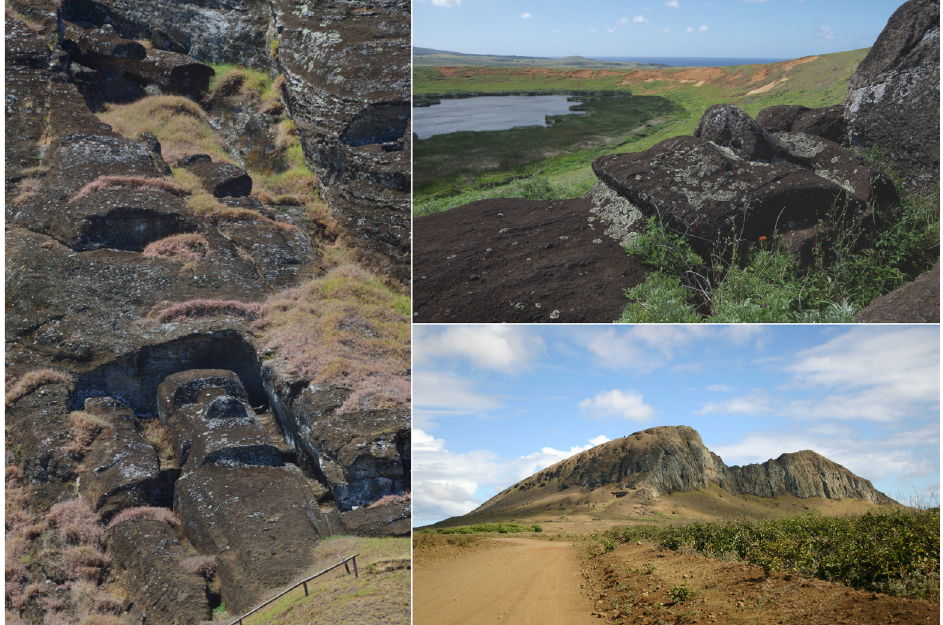
Fig. 6: Rano Raraku statue quarry. Clockwise from left: statues remaining attached to the quarry rock on the crater exterior; the interior of Rano Raraku showing the crater lake and (at the right-hand bottom) the head and upper torso of a large in situ statue; and view of the exterior (photos: M. Seager